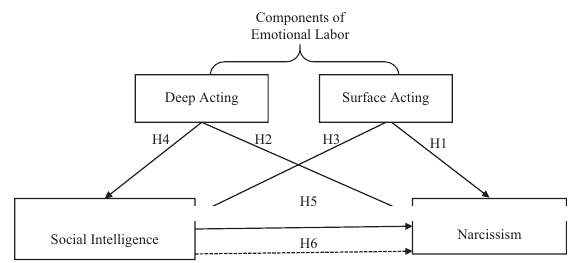
Fig. 1 Conceptual framework. Note: H1 = alternate hypothesis 1, H2 = alternative hypothesis 2, etc.; direct effect (-); indirect effect (-